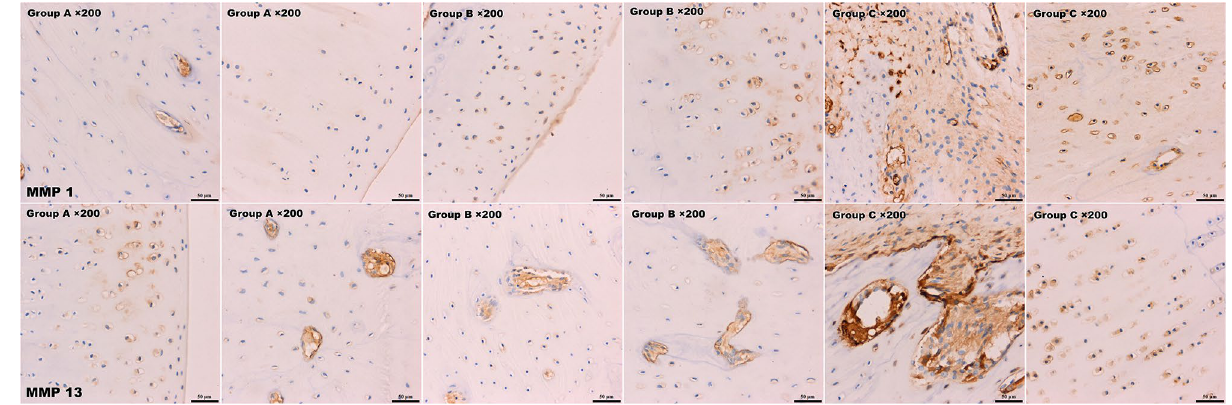
Figure 8. IHC of MMP-1/13. Both MMP-1 and MMP-13 were expressed at significantly higher levels in group C than groups A and B. MMP-1- and MMP-13-positive cells are shown in